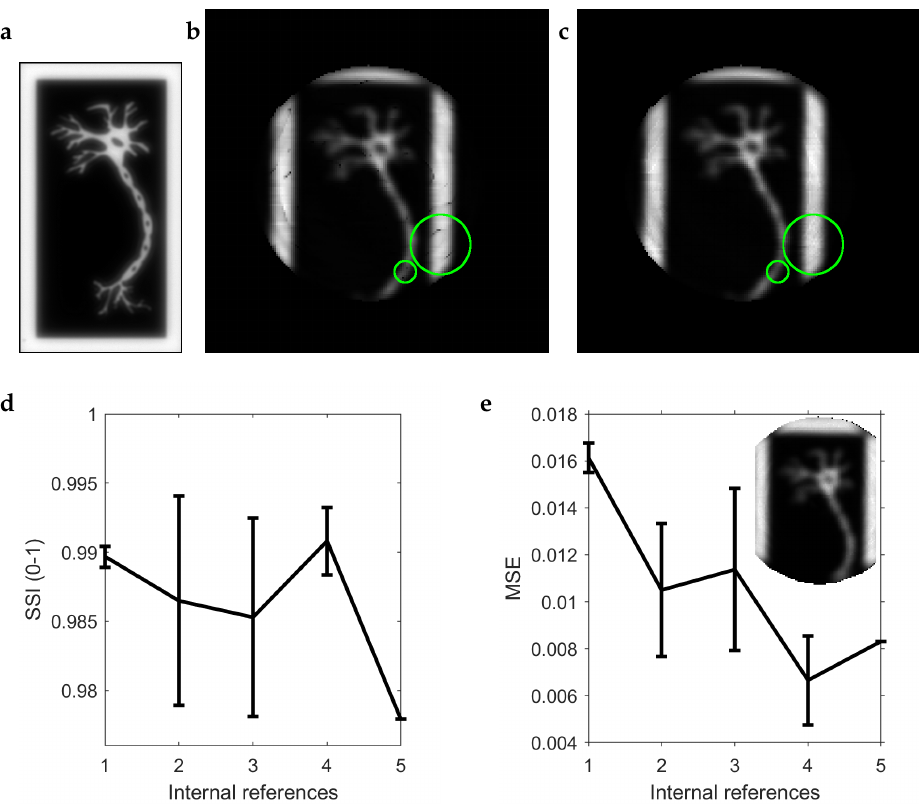
Figure 5. Neuron schematic image (height of 50 µm) recorded with light microscopy ( a ) and images from MMF endoscope calibrated with internal references. Combination of 1 and 5 internal reference waves were used to measure the TM. Green circles show some of the blind spots in 1 reference image ( b ) and the corresponding region of its 5-reference counterpart ( c ). The imaging quality comparison using structural similarity index ( d ) and mean squared error ( e ) used ground truth image shown as the inset of ( e